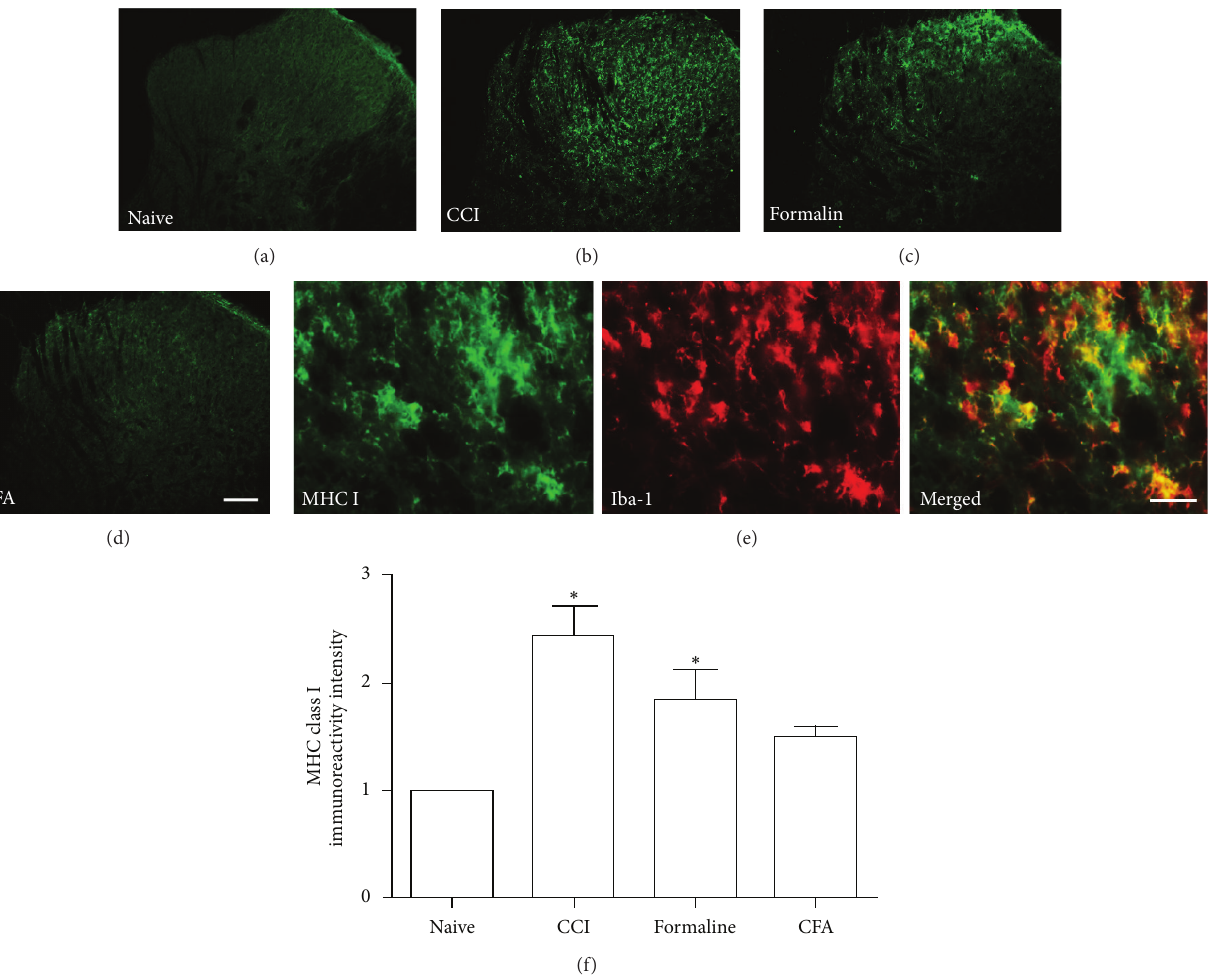
Figure 3: Significant upregulation of MHC class I expression was found in the spinal cord of CCI and formalin-injected rats but weak expressed in CFA-injected rats ((a)–(d) Scale bar, 100 𝜇 m). MHC class I positive cells were colocalized with Iba-1 ((e) Scale bar, 30 𝜇 m). The intensity of MHC class I immunoreactivity was quantitatively compared among four groups (f). ∗ 𝑃 < 0.05 , as compared with the na¨ıve